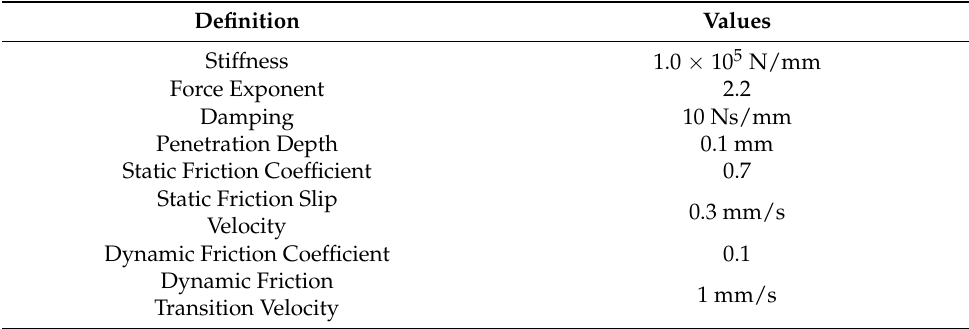
Table 3. Values of contact forces between robot suction cup and supporting surface.